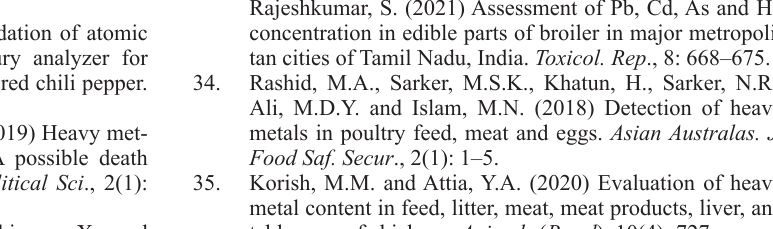
table eggs of chickens. Animals ( Basel ), 10(4):